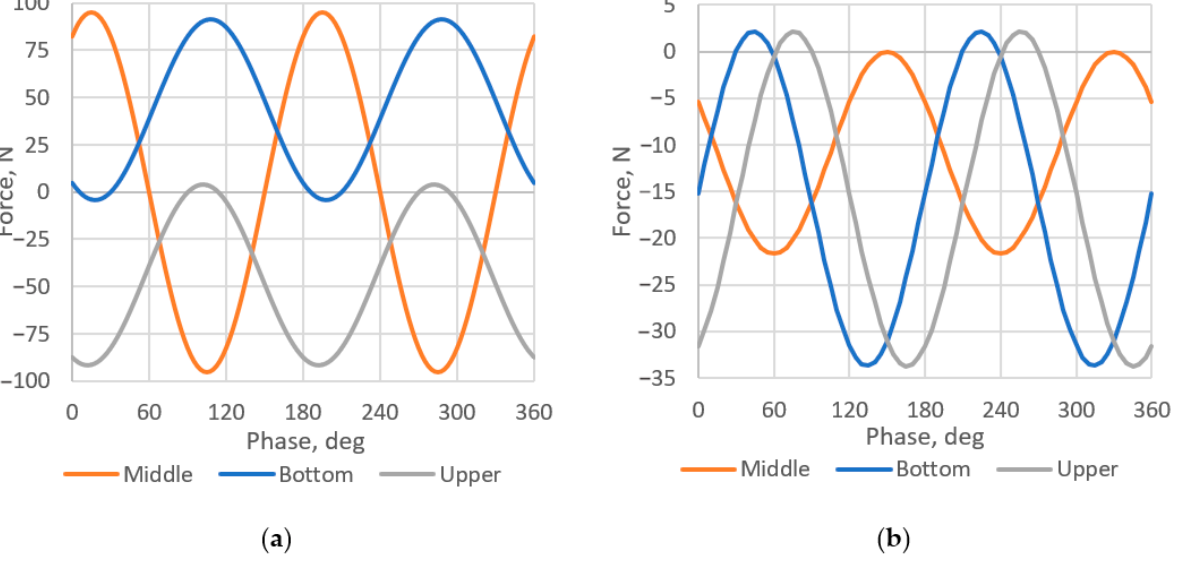
Figure 4. Instantaneous forces acting on stranded cables near a non-conductive core plate in ( a ) x direction; ( b ) y direction (d = 30 mm, L = 200 mm, Δ x = 60 mm, Δ y = 40, H = 600 mm, I = 10 kA)